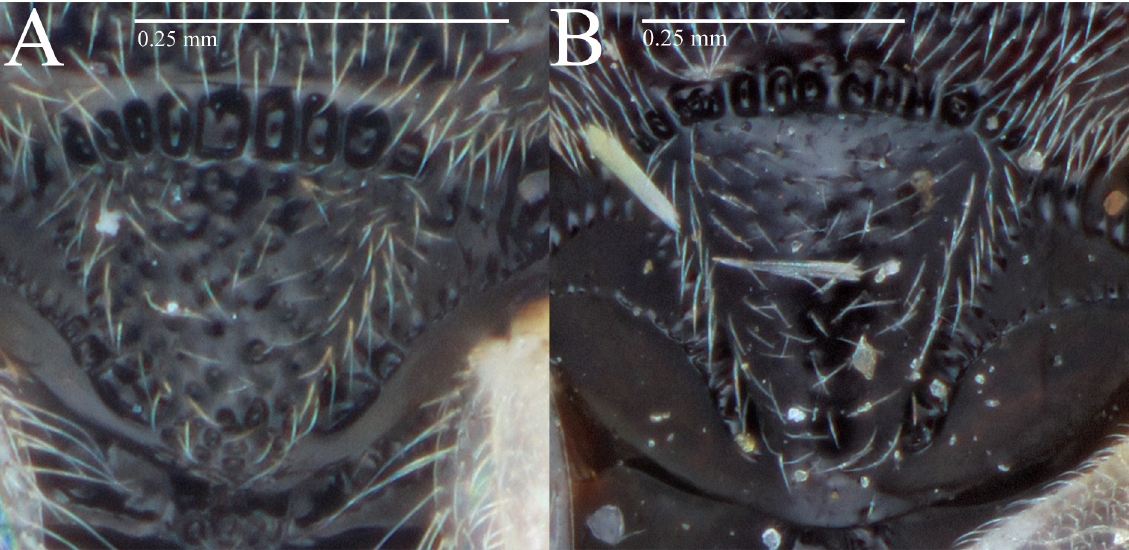
Scutellar disk smooth or with small punctures associated with setae (Fig. 3B).............................4